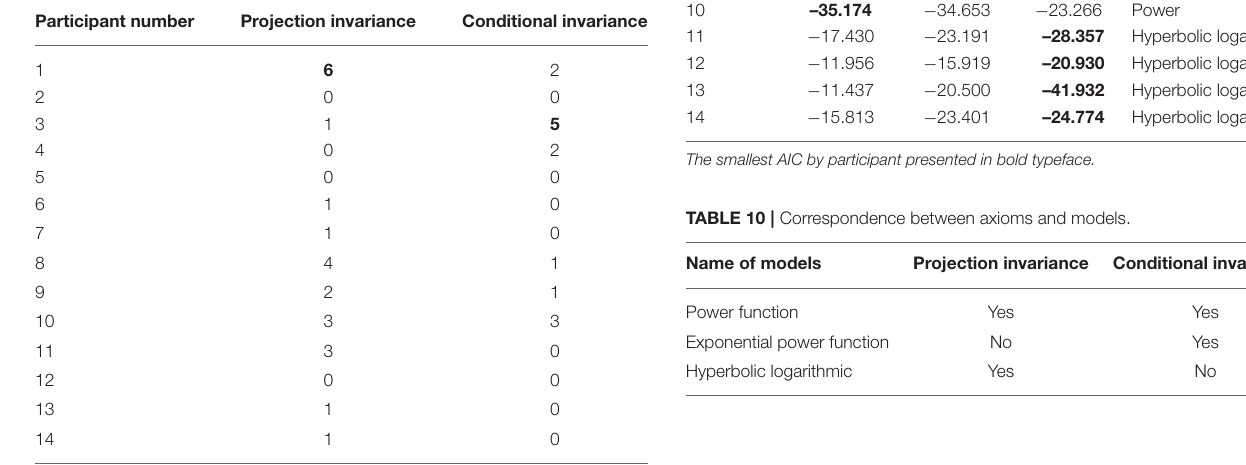
TABLE 7 | Number of sequences satisfying the axiom (out of 9 sequences).